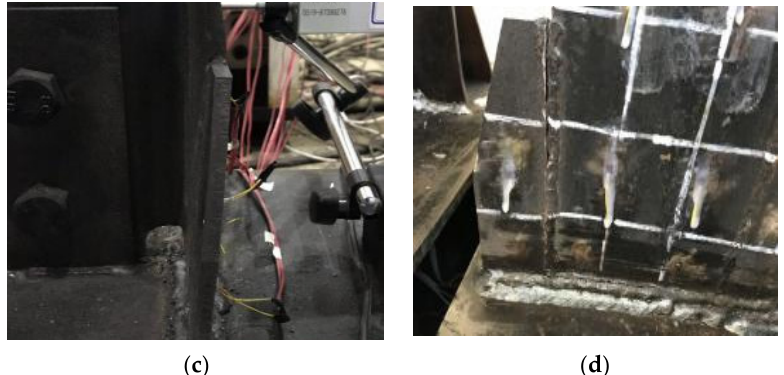
Figure 5. SRN specimen failure mode: ( a ) plastic hinge position; ( b ) weld failure form; ( c ) flange failure mode; ( d ) C-side flange failure form.